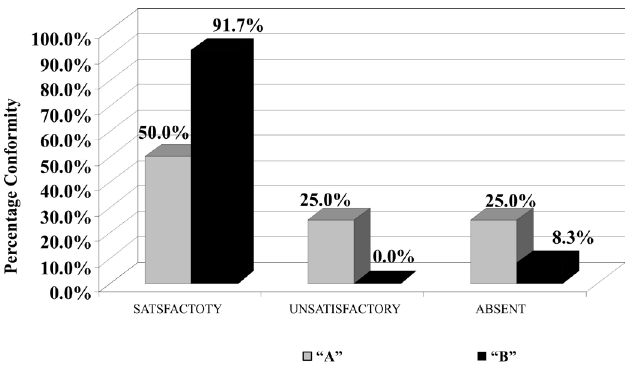
FIGURE 4 – Evaluation of the item “Compulsory Statements” for manufacturer “A” and “B” of P. sidoides –based phytotherapeutics